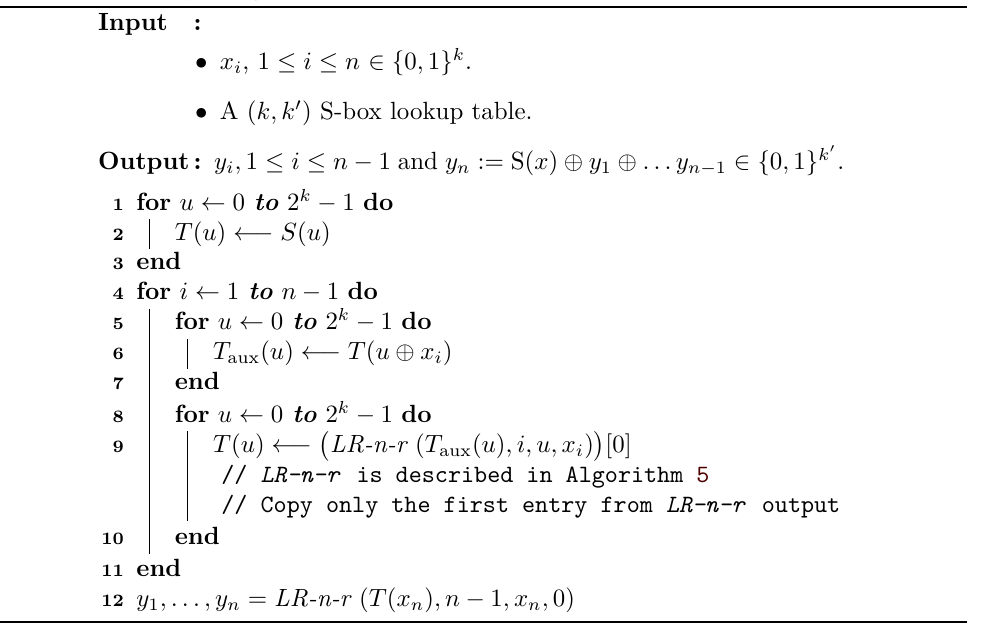
Algorithm 4: Higher-order masked lookup table computing output masks on-the-fly using robust PRG.